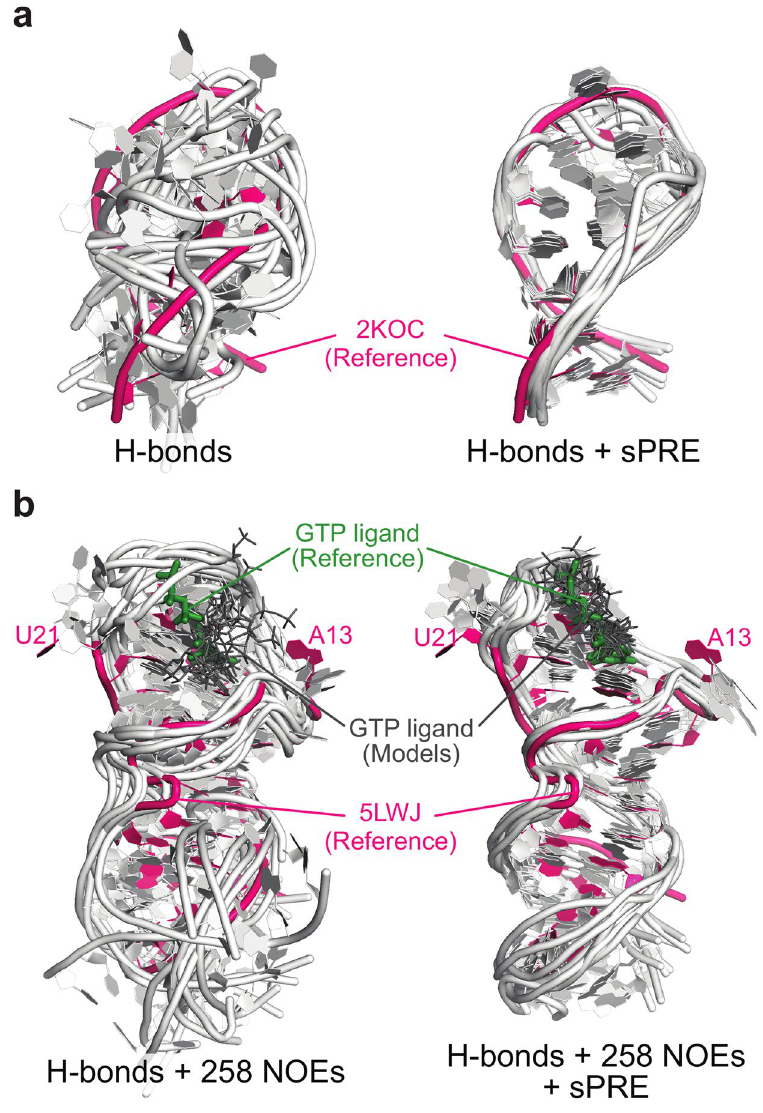
Figure 3. sPRE data improve structure determination of RNAs. Structural models of the UUCG tetraloop ( a ) and the GTP-bound GTP aptamer ( b ) were obtained without (left) and with (right) sPRE data using XplorNIH. The 10 best scored models (light gray) in terms of total energy were selected from a total of 200 models and aligned to the corresponding NMR structure (magenta). All restraints used in the computations are indicated below the respective models. In ( b ) heavy atoms of the GTP ligand are shown as sticks (Reference in green, computed models in dark gray) and the positions of the intrinsically flexible nucleotides A13 and U21 40 are